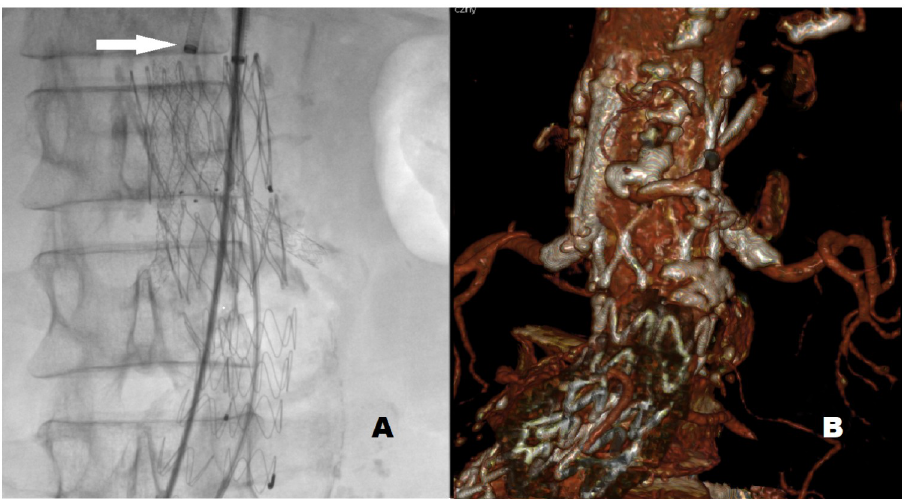
Fig 1. Stentgraft and chimney stents after implantation. A. Angiographic picture during the procedure (arrow -guide catheter for chimney stent implantation and pressure wire delivery). B. Follow up computed tomography after 6 months—patency of both chimney stents.